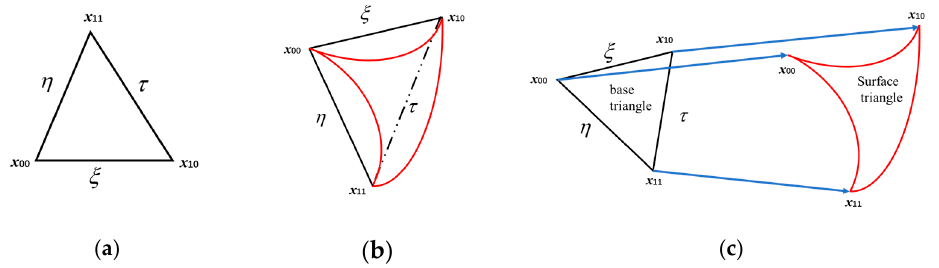
Figure 3 . Curved triangle parameters: ( a ) parameters of each side; ( b ) curved triangle; ( c ) mapping of parameter fi elds.